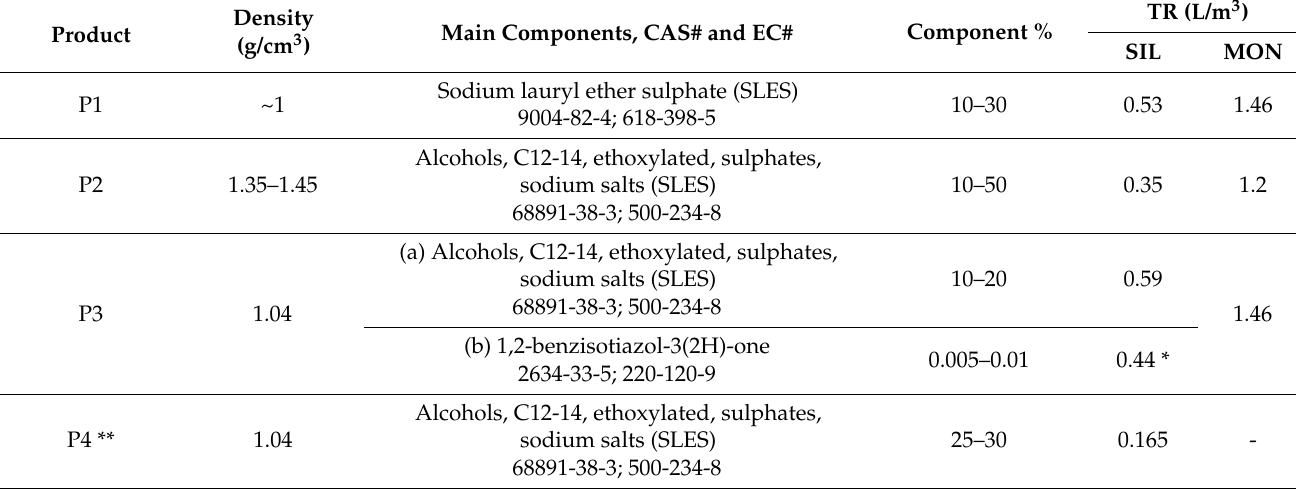
Table 1. Foaming agent products (P) and their relative amount used for the soil conditioning. The product density, main components, CAS#, EC# and component % are those reported in the chemical safety data sheets of the commercial products. P4 was used together with P3. SIL: sandy-silty-clay soil; MON: gravel in a sandy-silty soil. The foaming agent amount to be applied in each soil (TR: soil Treatment Ratio) was assessed by slump conic